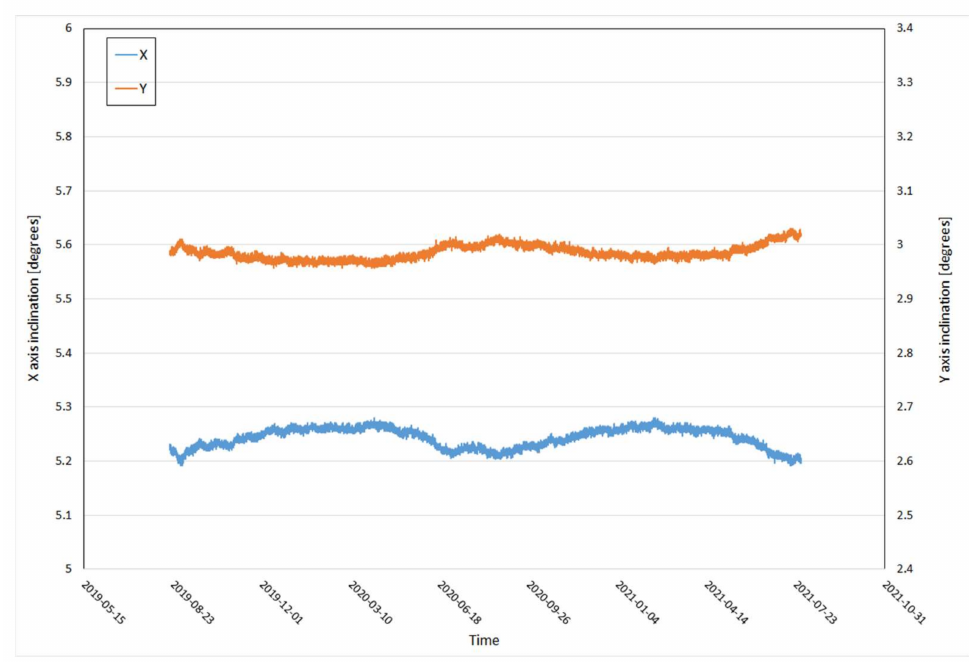
Figure 17. Changes in the slope (X and Y components) recorded at the first station with the sensor installed in the roof of the excavation